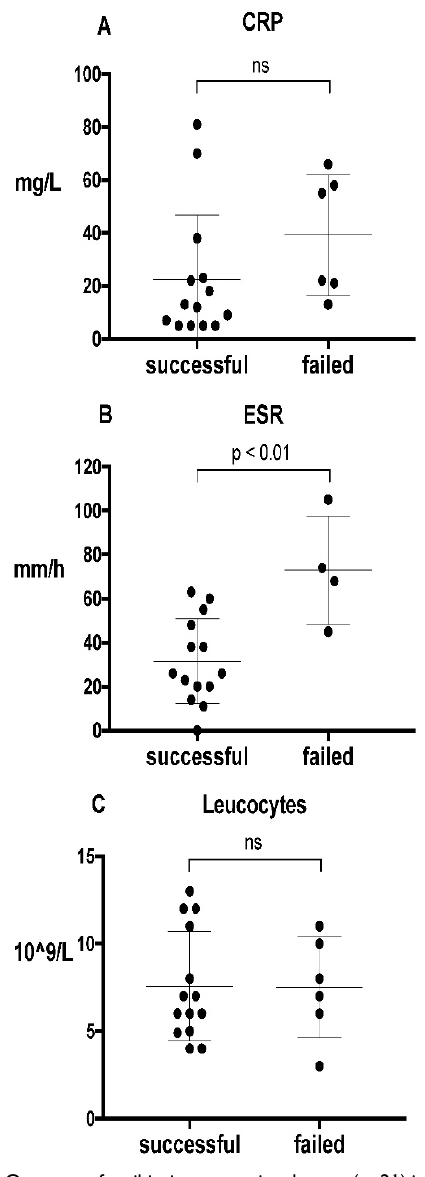
Figure 2 . Outcome of antibiotic suppressive therapy (n=21) in relation to inflammatory parameters before suppression therapy was started); C-reactive protein (CRP) (A), Estimated Sedimentation Rate (ESR) (B), and leucocytes (C). The definition of successful treatment and failed treatment is descripted in the text. Bars represent the median, the 25 th and the 75 th